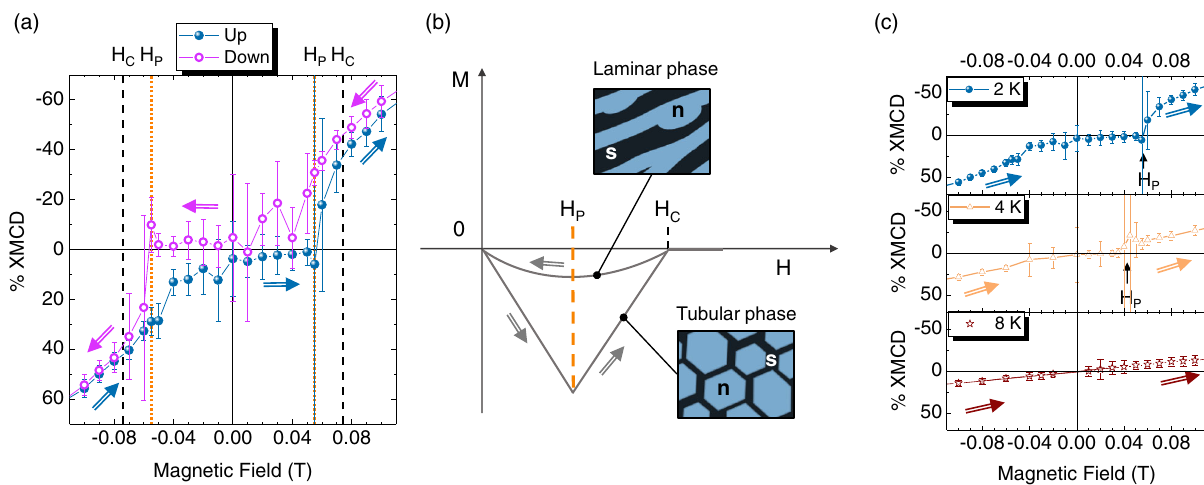
Fig. 3 Magnetic behaviour of the TbPc 2 sub-monolayer on Pb(111) across the superconducting transition. a Magnetisation curves of TbPc 2 monolayer on Pb(111) at 2 K and θ = 0° within the critical fi eld of the superconductor ( H C ). The complete magnetic fi eld screening effect of Pb is observed for increasing magnetic fi eld intensity within a certain fi eld H P . The arrows indicate the fi eld scan direction. b Sketch of a typical magnetisation loop of disk shaped Pb single crystals (see ref. 12 ). The hysteresis loop of bulk Pb crystals originates from the different topology of the intermediate state when the magnetic fl ux penetrates or is expelled from the substrate. The topology (tubular and laminar) of the micrometric superconducting ( s ) and normal ( n ) domains in the intermediate state depicted in the fi gure is representative of the magnetooptical images of Pb crystals of ref. 12 c Magnetisation curve (up branch) of TbPc 2 on Pb(111) for θ = 0° at different temperatures below (2 K and 4 K) and above (8 K) the critical temperature. Error bars in panels a and c indicate the Standard Deviation (SD) of the signal at each fi eld (see